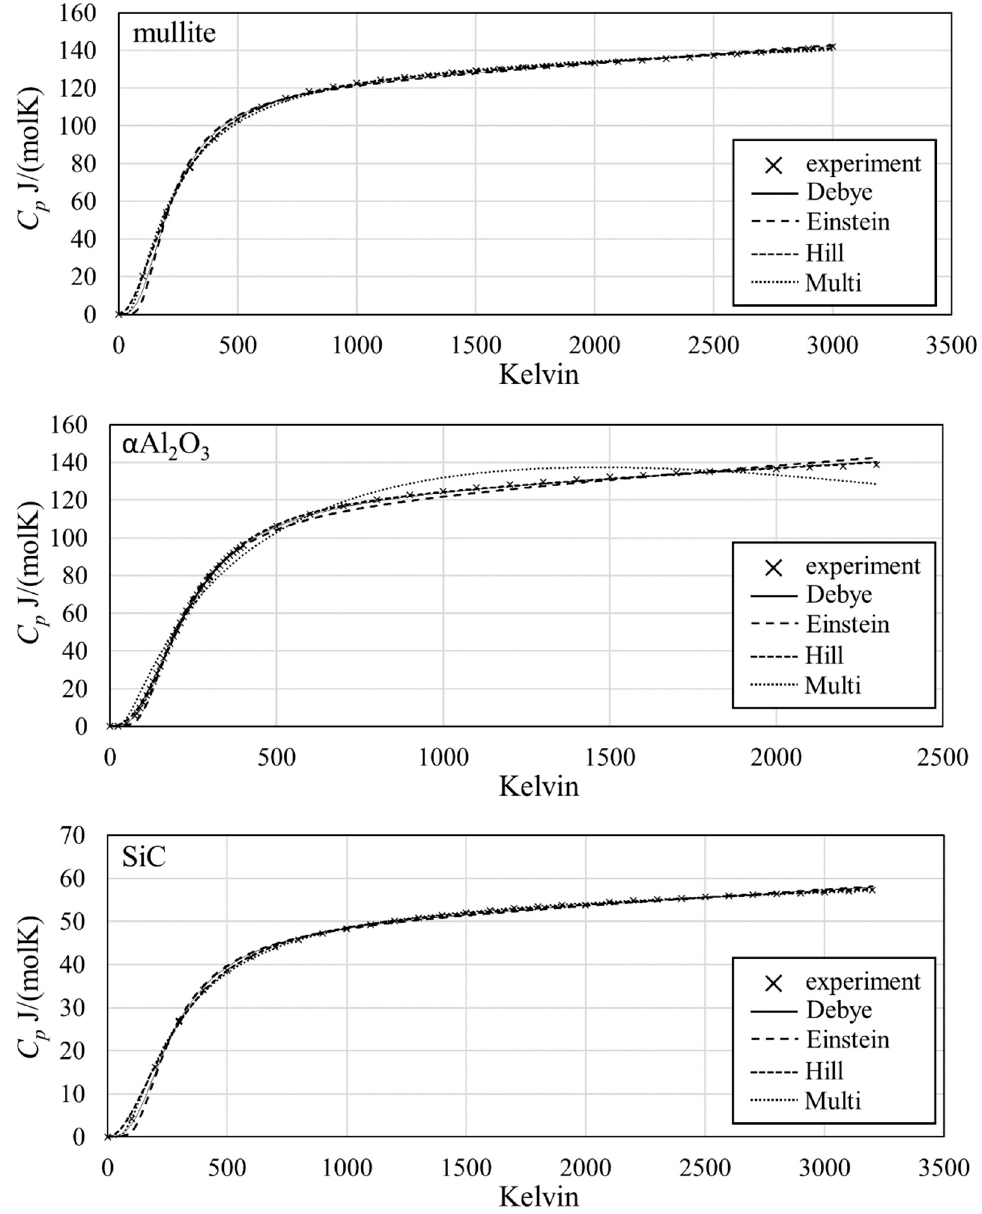
ChemEngineering 2022 , 6 , x FOR PEER REVIEW Figure 4. Model predictions for the specific heat of example technical and refractory ceramics.